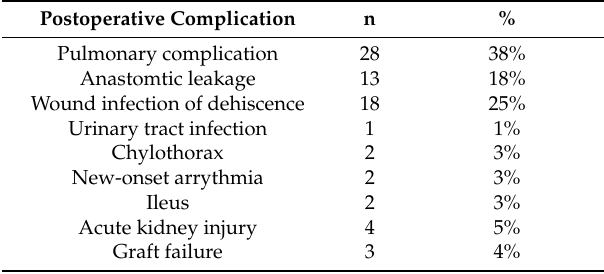
Table A2. Postoperative complications after esophageal cancer